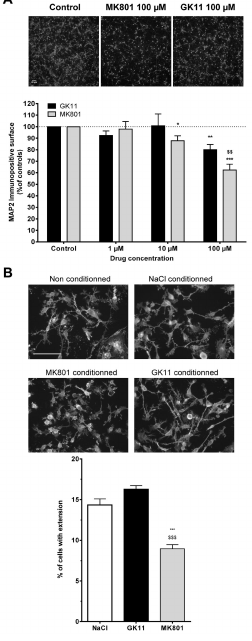
Figure 5. MK801-elicited microglial activation is caused by neuronal injury. ( A ) Comparison of the intrinsic neurotoxicity of GK11 or MK801 on densely seeded and mature cortical cultures. Neuronal cultures were challenged for 48h with increasing concentrations of the NMDAR antagonists. Neuronal suffering was assessed by determining the MAP2- immunopositive surface. Photographs